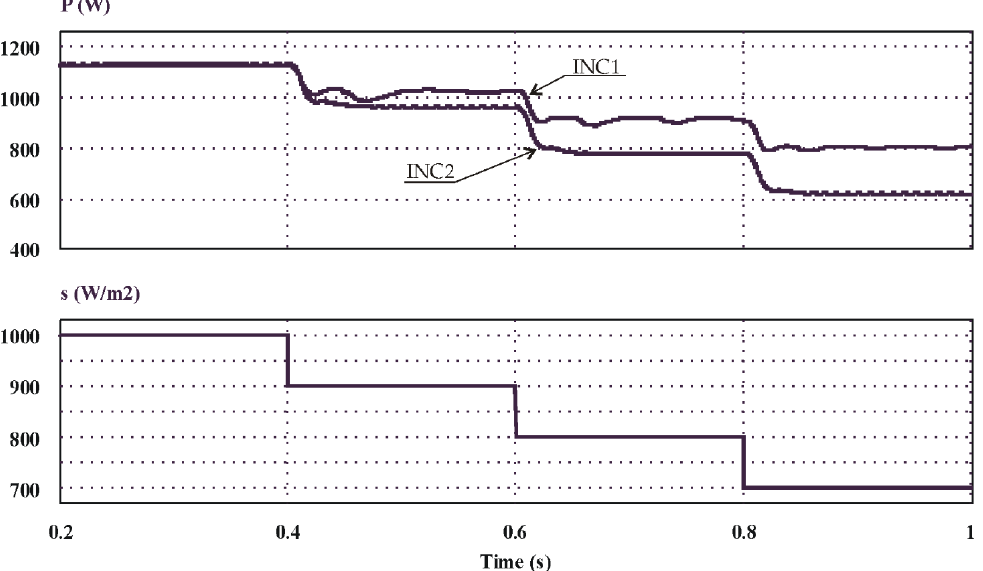
Figure 8. Measured power P in W delivered to the grid and solar irradiance s in W / m 2 for the proposed MPPT method (INC1) and for the incremental conductance MPPT method (INC2) with the increment value tuned for solar irradiance of 1000 W / m 2 . Energies 2020 , 13 , x FOR PEER REVIEW